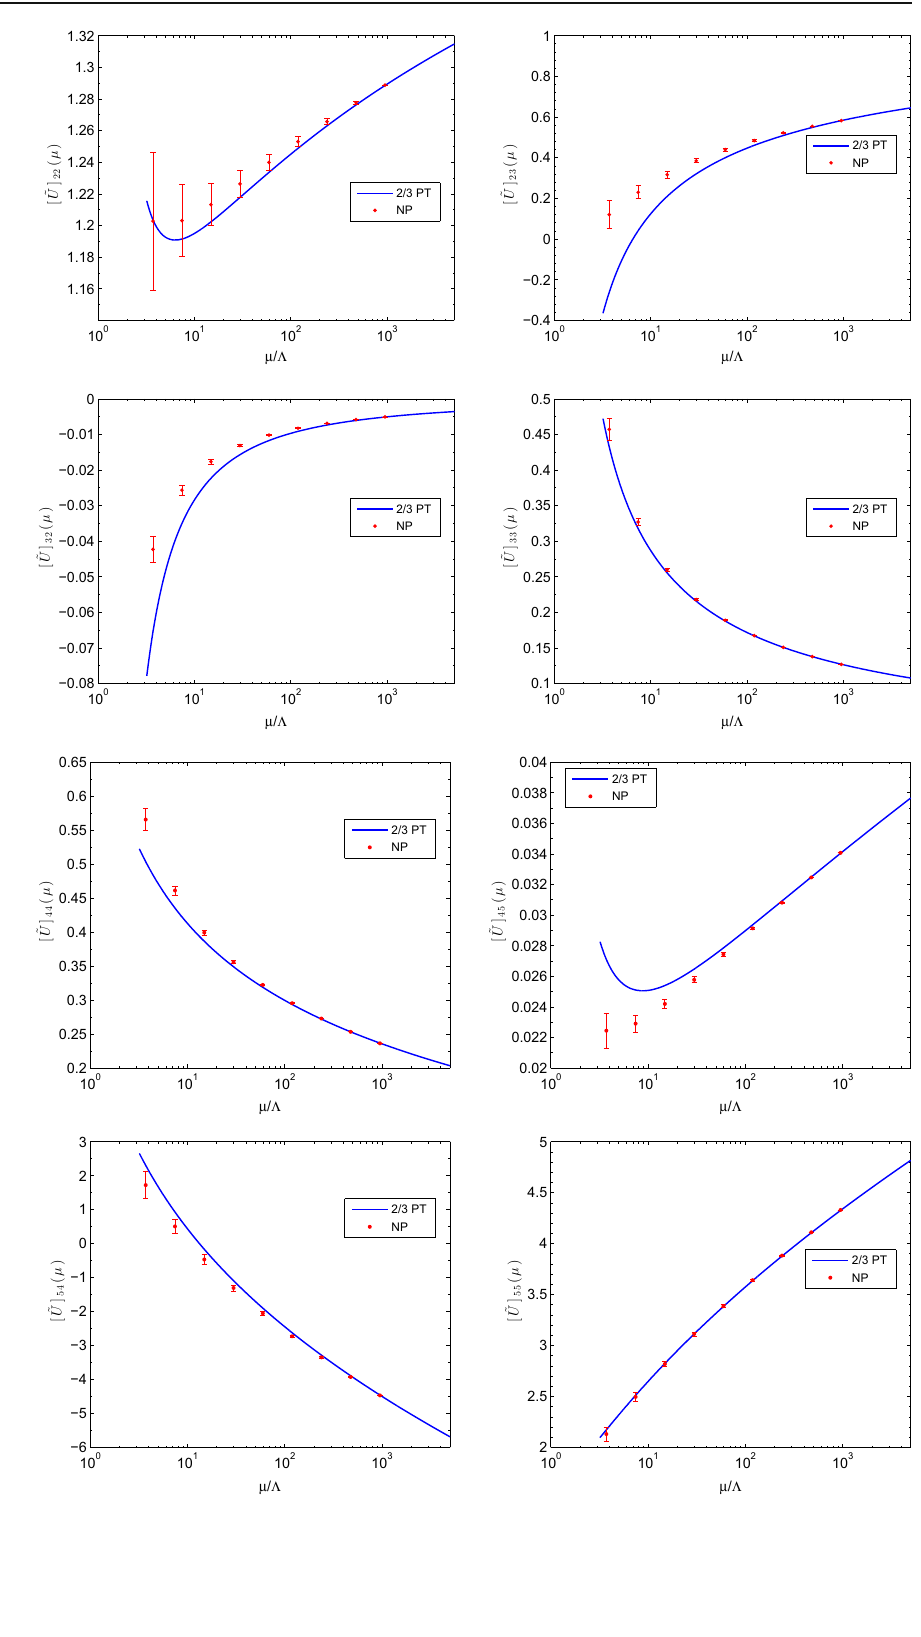
10 0 10 1 10 2 10 3